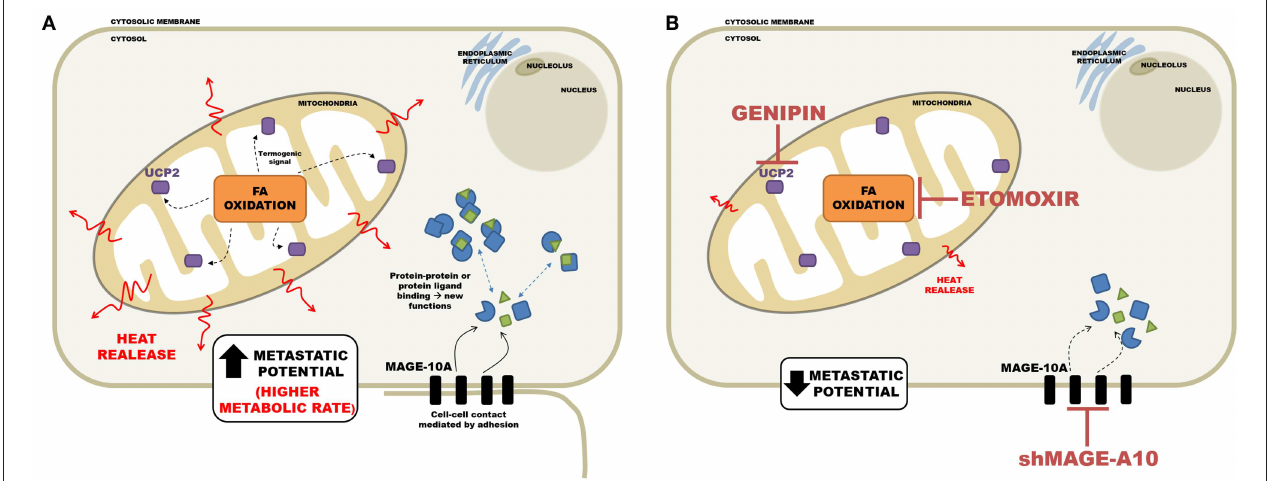
FIGURE 9 | Schematic representation of the relationship between metastatic potential and heat release in the tumor cell. (A) Cell with high metastatic potential has important proteins for regulating functioning cell-cell interaction and migration, such as MAGEA10; as well as an active mitochondria, the communication between β -oxidation and high levels of UCP2, resulting in a high thermogenesis. (B) Silencing of MAGEA10 and/or pharmacological inhibition of UCP2 and CPT1-A, results in less heat release. This suggests an important participation of these proteins in thermogenesis.